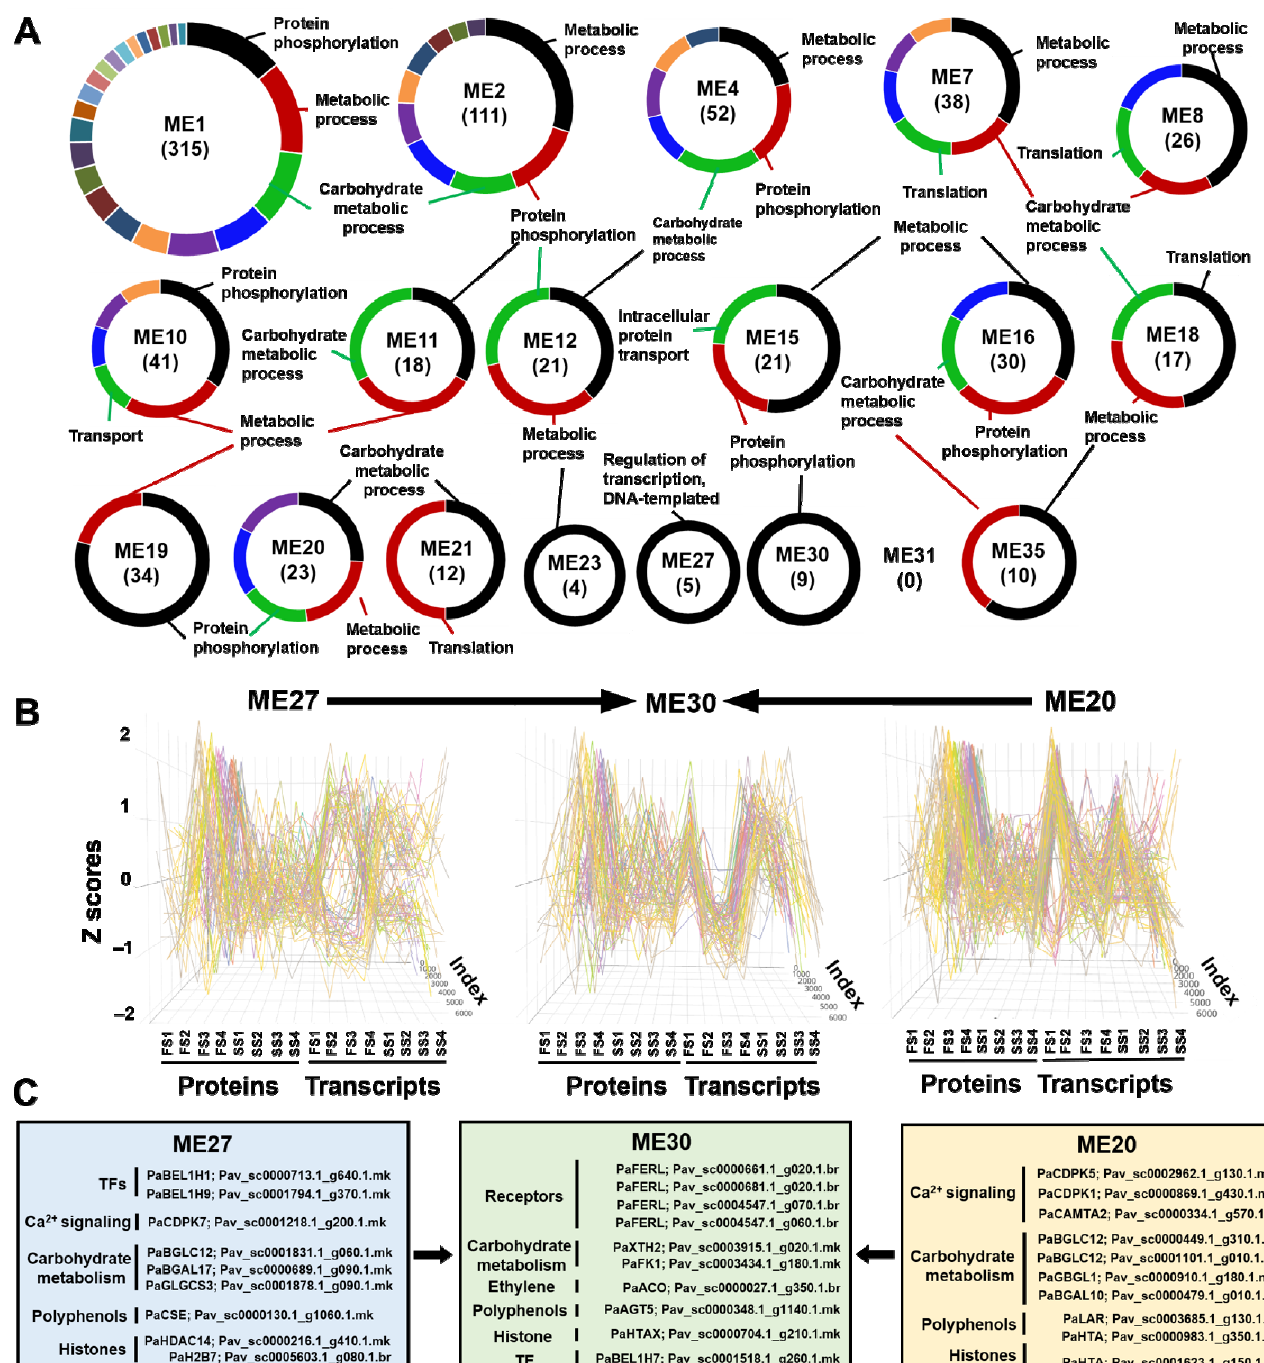
Figure 4. ( A ). Gene ontology (GO) categories regarding biological processes (BP) of 19 modules that were displayed in at least four transcripts/proteins. Parentheses indicate the number of unique genes/proteins that are classified in BP-GO. ( B ). Z-score trend lines of proteins and transcripts across four fruit (FS) and stem (SS) stages in modules ME27, ME30, and ME20. ( C ). Specific genes/proteins of ME27, ME30, and ME20 that are classified in ripening related groups. Arrows indicate direct effects between modules. Data provided in Supplementary Tables S3 and S4.